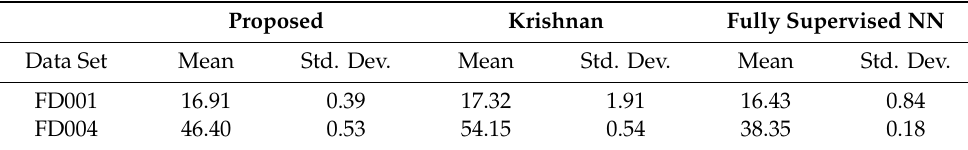
Table 8. Unsupervised RMSE average results for the C-MAPSS test set.